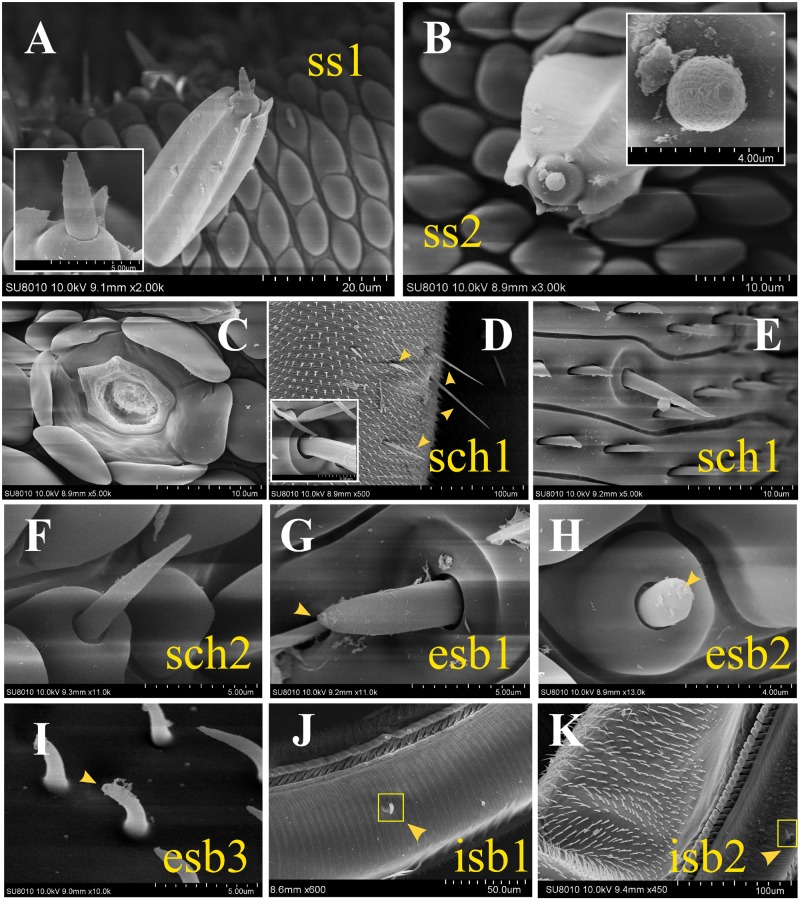
Scanning electron micrographs of sensilla on the proboscis of adult H. armigera. (A) Sensilla styloconica subtype 1 (ss1) possessing a uniporous cone. (B) Sensilla styloconica subtype 2 (ss2) with a multiparous sphere. (C) The lotus-shaped pedestal of sensilla styloconica. (D) Long and short sensilla chaetica subtype 1 (sch1) on the proximal section. The cupped socket at the base of sch1 (white box). (E) Short sensilla chaetica subtype 1 (sch1) on the middle section. (F) Sensillum chaetica type 2 (sch 2) on the distal part of the proboscis. (G) External sensilla basiconica subtype 1 (esb1) with a basal socket and a top pore. (H) External sensilla basiconica subtype 2 (esb2) on a roof-shaped bulge and with a pore on the tip. (I) External sensilla basiconica type 3 (esb3) with an uniporous peak and a curving cone. (J) Internal sensilla basiconica type 1 (isb1) on the internal surface of the proboscis tube. (K) Internal sensilla basiconica type 2 (isb2).